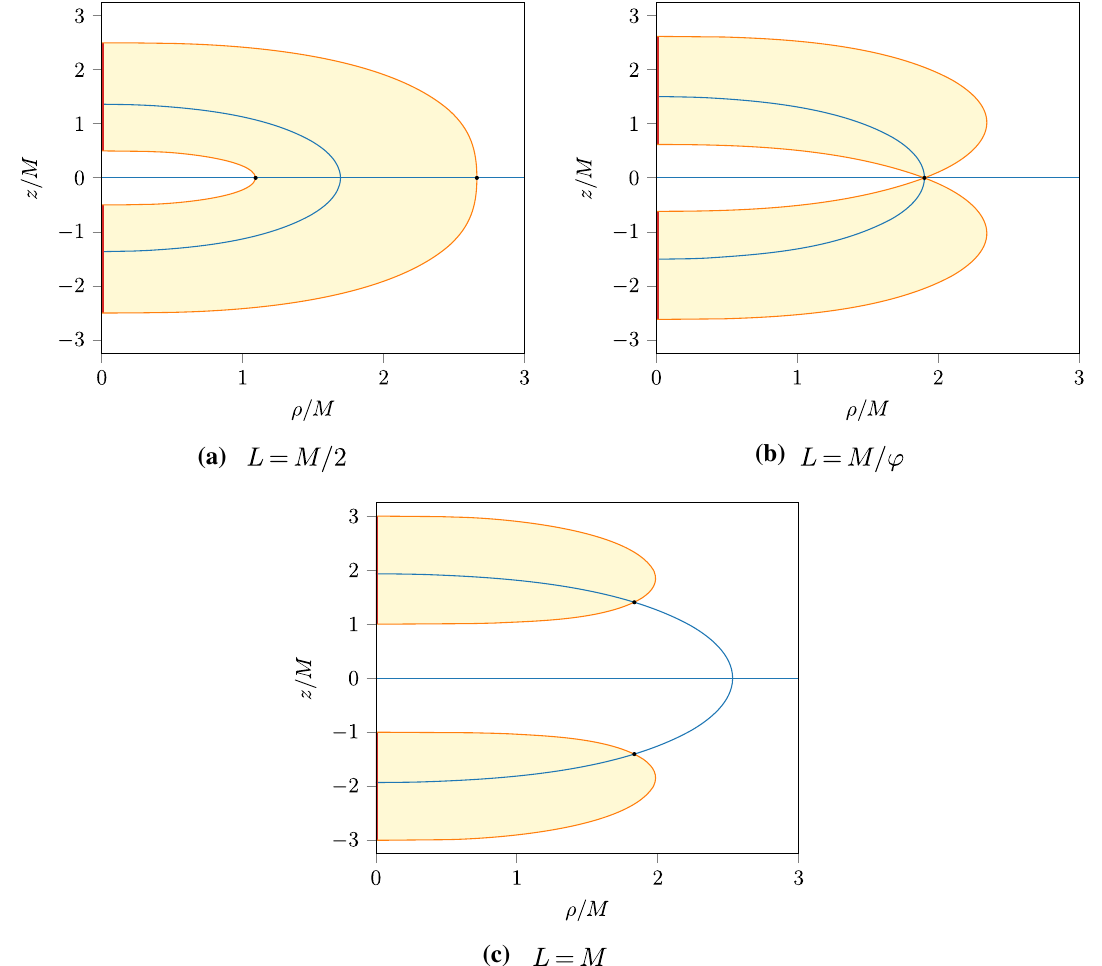
The yellow regions denote the points at which ∂ ρ H (ρ, z ) < 0 (equiv- alently, 1 − 2 ρ∂ ρ U (ρ, z ) < 0); this information will be needed in